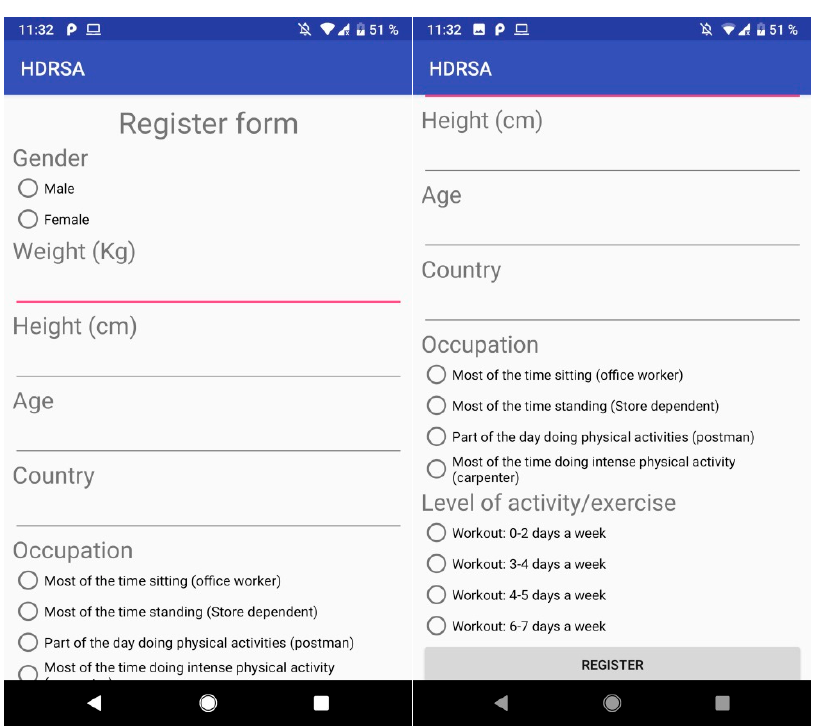
Figure 1. Mobile application Human Dynamics Reporting Service (HDRS) registration forms.